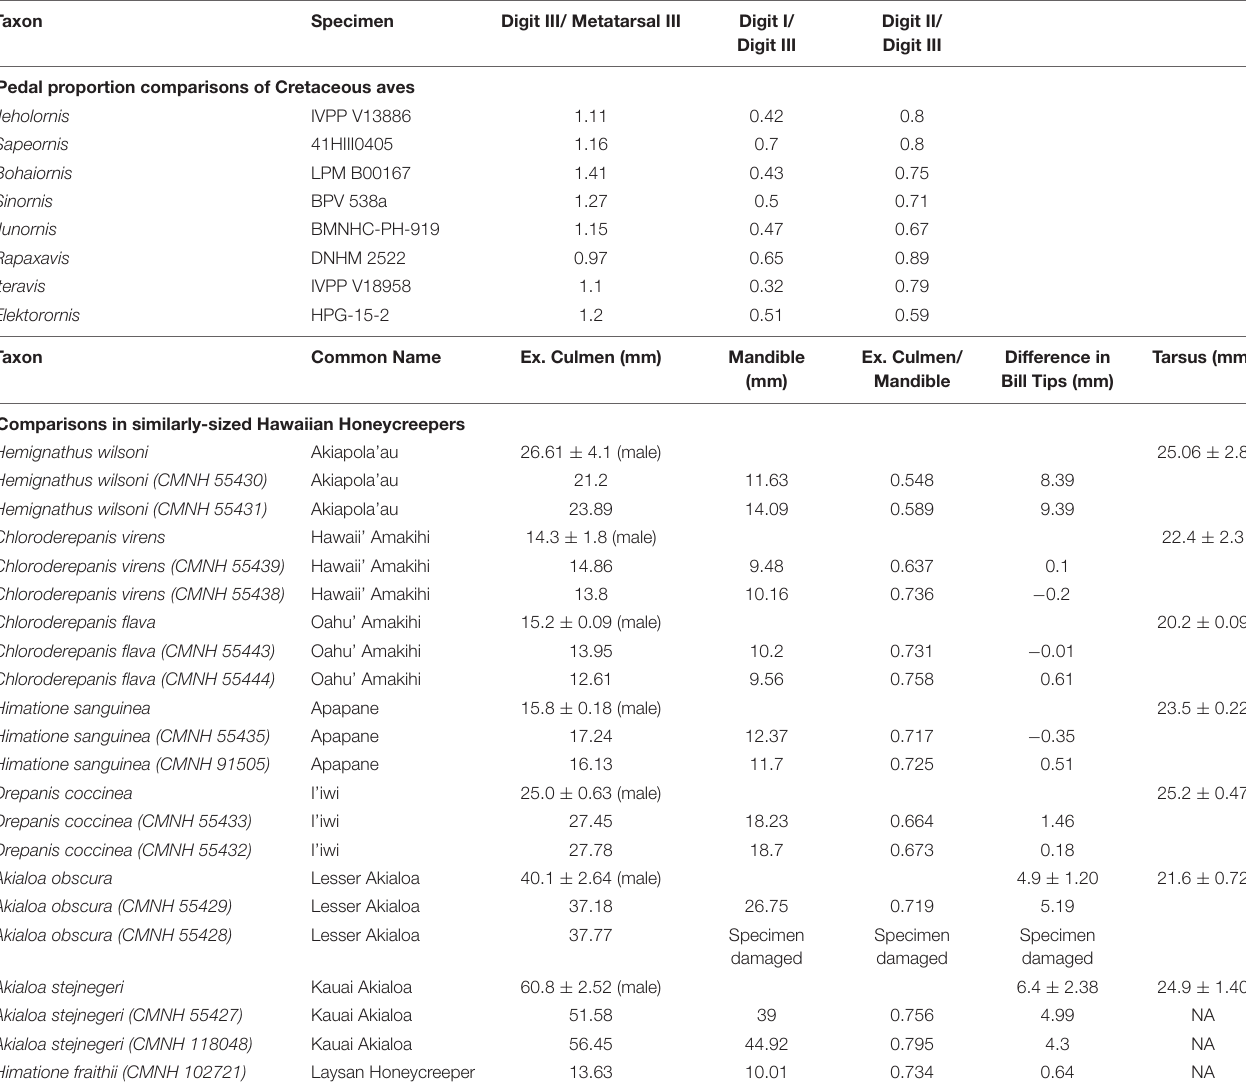
TABLE 1 | (Top) Comparisons of pedal digit proportions between Cretaceous aves and (Bottom) upper and lower bill lengths in eight species of Hawaiian honeycreeper. Taxon